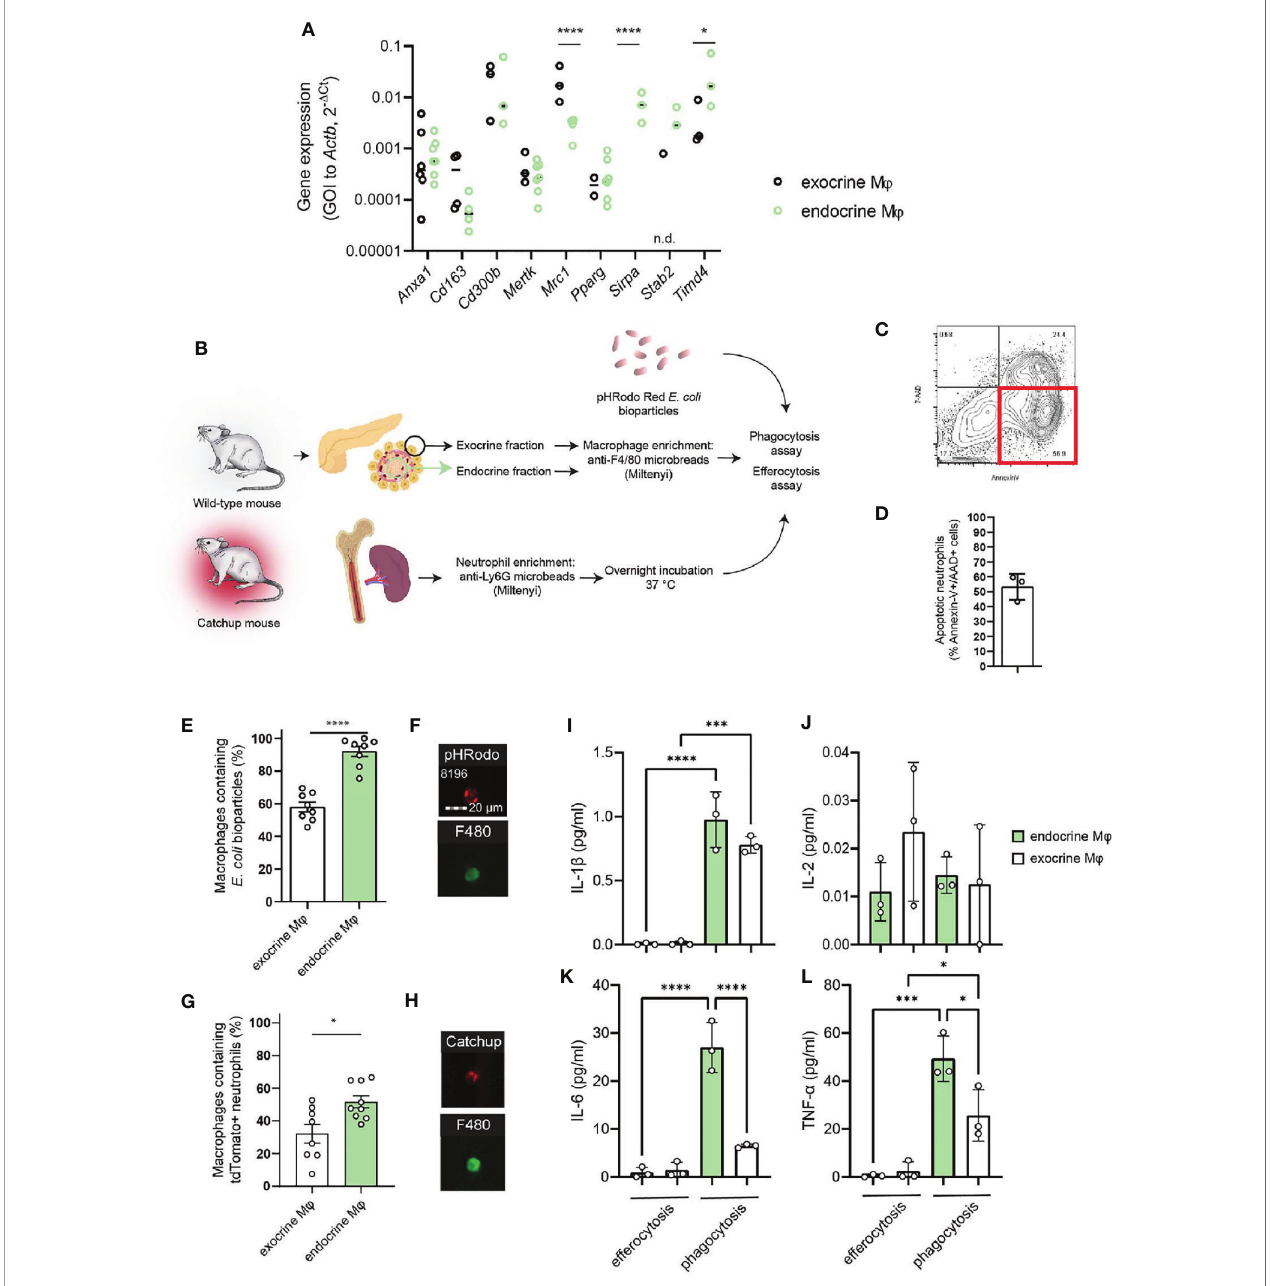
FIGURE 2 | Endocrine-resident macrophages are ef fi cient in phagocytosis and efferocytosis in vitro . (A) A selection of phagocytosis-related genes were assessed by qPCR in macrophages from the endocrine and exocrine fractions, respectively. No distinct pattern suggesting functional impairment between macrophages from the two compartments could be observed other than the very low expression of MMR in endocrine-resident macrophages (n=3-7 mice per group, *P > 0.05, ****P ≤ 0.0001, 2-way ANOVA, n.d.=not detected). (B) Schematic of work fl ow for phagocytosis and efferocytosis assays. (C, D) Flow plot and quanti fi cation of the fraction of Catchup neutrophils being in a pre-apoptotic state for the efferocytosis assay. (E) Endocrine-resident macrophages were signi fi cantly more ef fi cient in phagocytosis of pHrodo E.coli bioparticles than exocrine-resident macrophages (n=8 mice, ****P < 0.0001, Mann-Whitney U test). (F) Images from the FlowSight fl ow cytometer demonstrating the internalization of red- fl uorescent bacterial particles and positivity for the pan-macrophage marker F4/80. (G) Endocrine-resident macrophages were also more ef fi cient in efferocytosis of dying neutrophils than exocrine-resident macrophages (n=9 mice, *P < 0.05, Mann-Whitney U-test). (H) Images from the FlowSight fl ow cytometer demonstrating the internalization of tdTomato-red fl uorescent neutrophil particles and positivity for the pan-macrophage marker F4/80. (I – L) Cytokine content in supernatants from efferocytosis and phagocytosis experiments for endocrine- and exocrine-resident macrophages (n=3 separate experiments in which macrophages from 2 mice were pooled per datapoint, *P < 0.05, ***P < 0.001, ****P < 0.0001, one-way